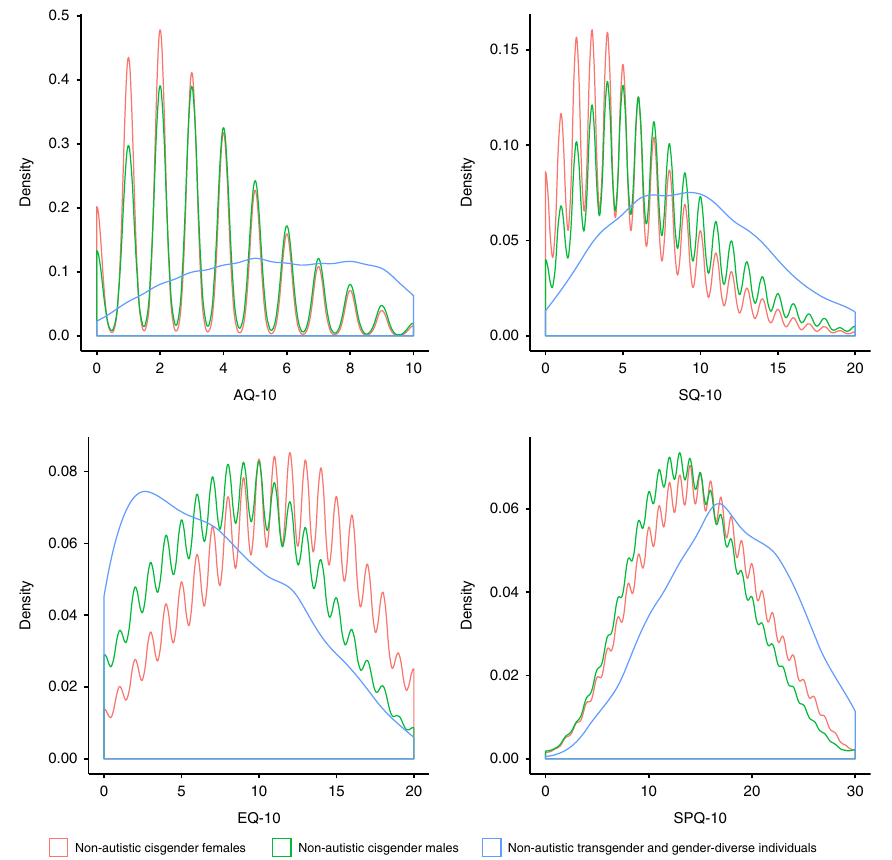
Fig. 3 Kernel density plot of scores on the four self-report measures in the C4 Dataset for non-autistic individuals only. This fi gure provides kernel density plots for scores on the four self-report measures (AQ-10, EQ-10, SQ-10, and SPQ-10) for non-autistic participants from the C4 dataset ( N = 514,100) based on their gender (cisgender males, cisgender females, transgender and gender-diverse individuals). Scales on the axes are different between the panels. See Supplementary Fig. S1 which provides kernel density plots for all four measures for both autistic and non-autistic individuals. The non-autistic transgender and gender-diverse kernel density plots appear smoother due to the relatively low number of participants included, hence providing less resolution in the kernel density estimates when compared to the non-autistic cisgender males and non-autistic kernel density